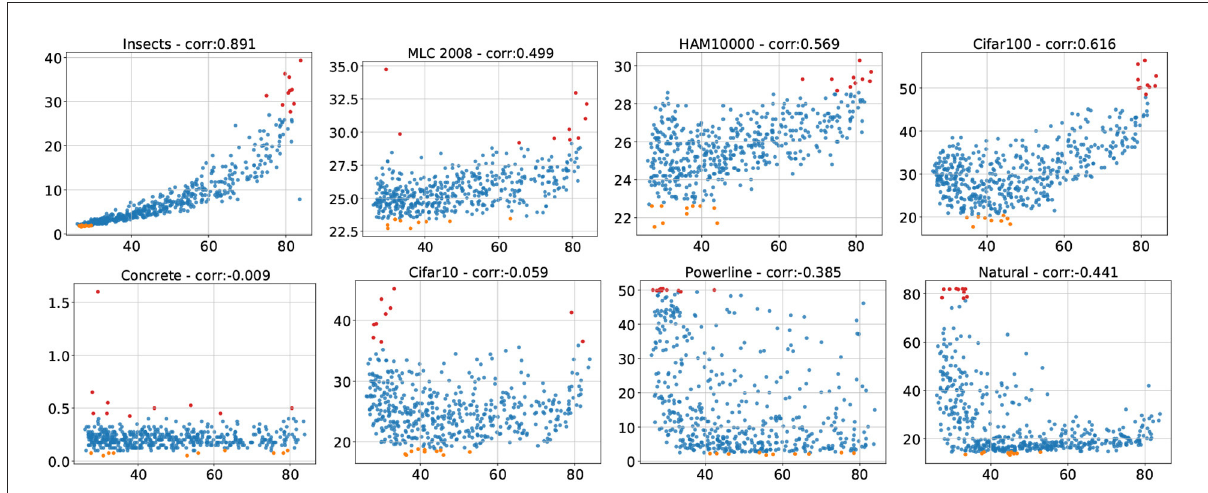
FIGURE3 Test errors of all 500 sampled architectures on target datasets (y-axis) plotted against the test errors of the same architectures (trained and tested) on ImageNet (x-axis). The top 10 performances on the target datasets are plotted in orange and the worst 10 performances in red.